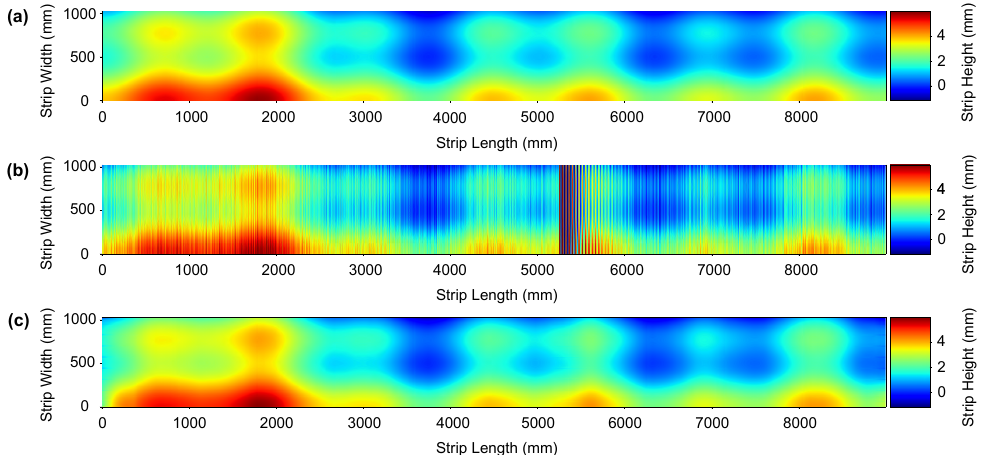
Figure 8. An instance of the denoising result on a synthetic strip. ( a ) Depicts the noise-free ground truth surface, ( b ) shows the noise corrupted surface, and ( c ) represents the denoised surface recon- structed using the proposed network. (Color online).